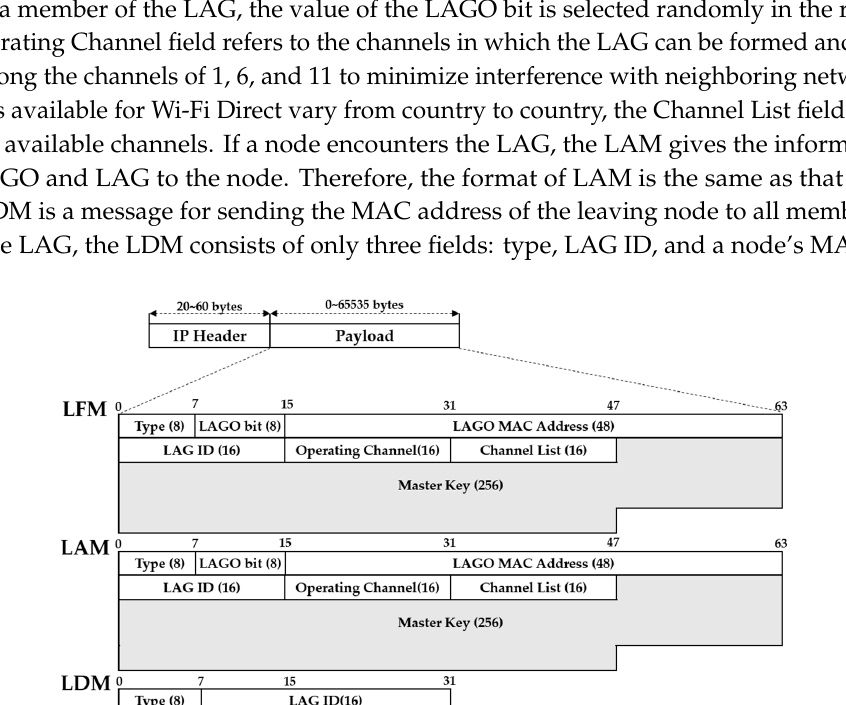
Figure 2. Messages of a traffic controller.